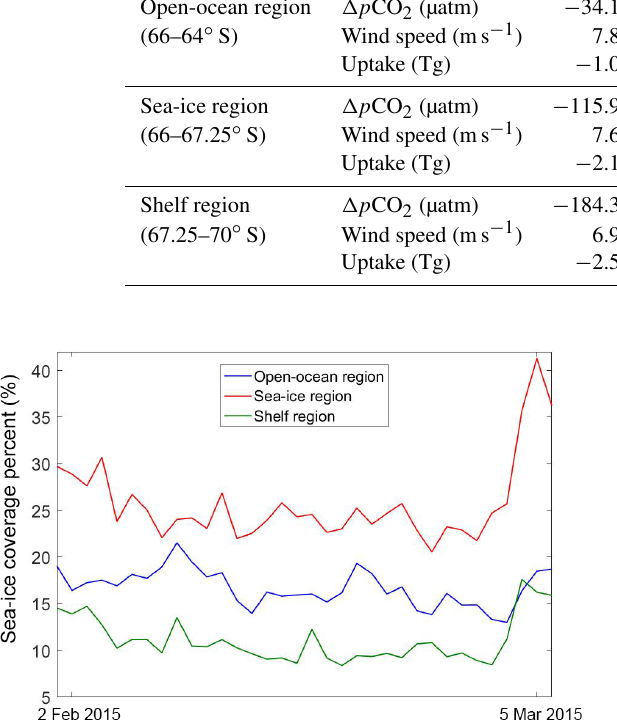
Figure 6. Percentage of sea-ice coverage in three subregions from 2 February to 5 March 2015 (blue represents the open-ocean region, red represents the sea-ice region and green represents the shelf re-